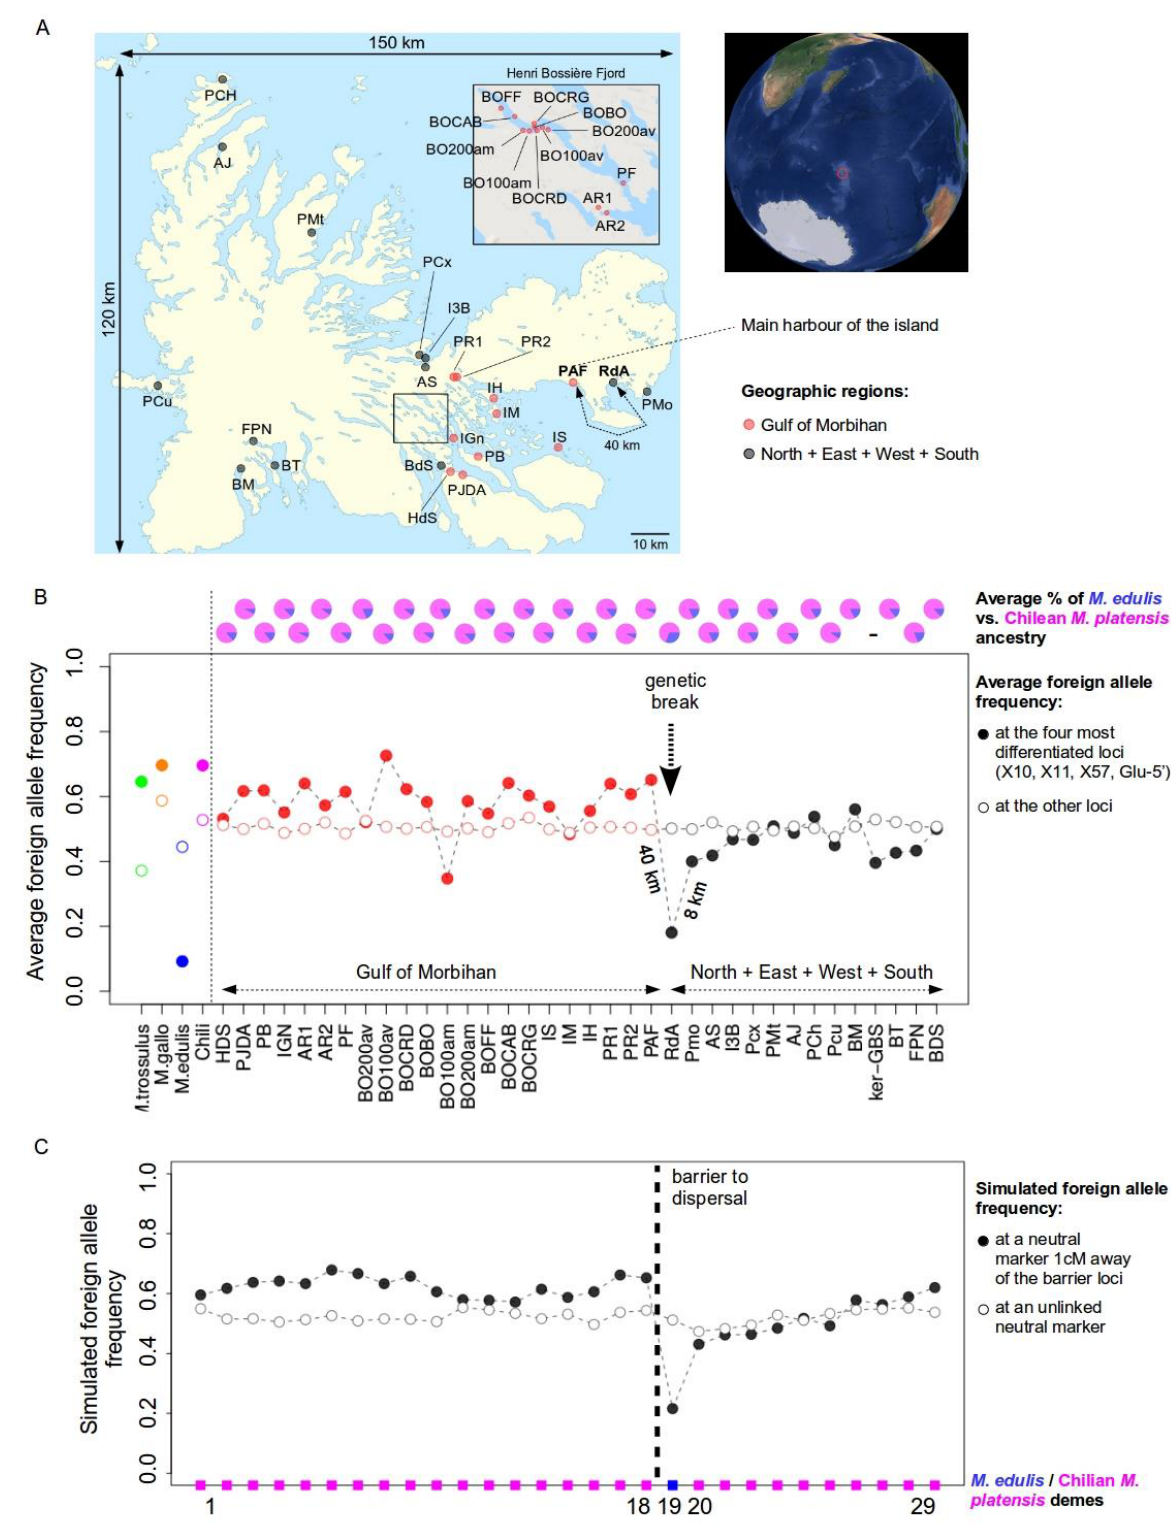
Figure 4. Geographic variation of the average foreign allele frequency across the four most differentiated loci in the Kerguelen Islands (filled symbols, X10, X11, X57 and Glu- 5’ from Gérard et al., 2015) and the other loci (open symbols). Alleles were labelled based on their frequencies in the M. galloprovincialis Atlantic population of Iberian Coast (Table S4). Red points indicate sites located in the Gulf of Morbihan. A. Map of the Kerguelen Islands (150 km East to West; 120 km North to South) together with a world map indicating